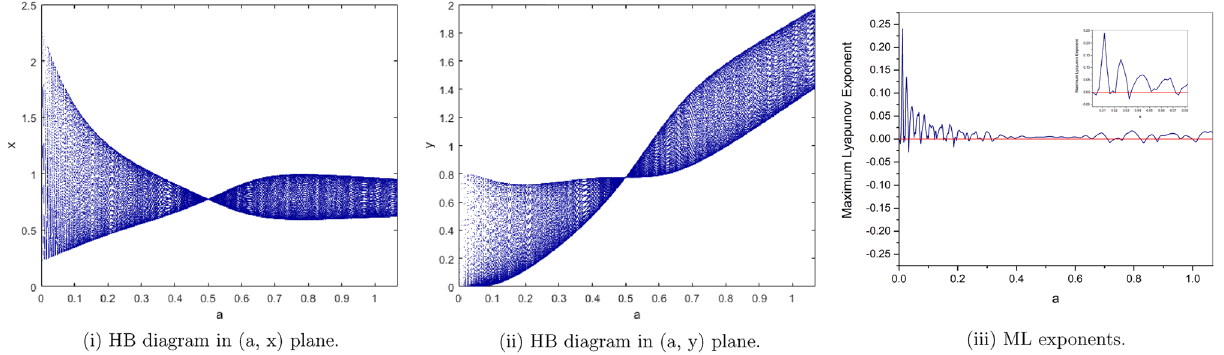
Figure 13. Bifurcation diagrams and ML exponents for the model (i) for values of b = 1.5, c = 0.5, e = 1.2, h = 0.5, a ϵ [0, 1.068].